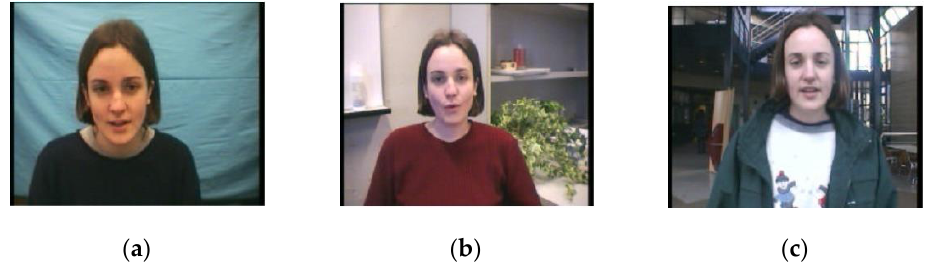
Figure 9. Facial examples from the BANCA database: ( a ) controlled, ( b ) degraded, and ( c )